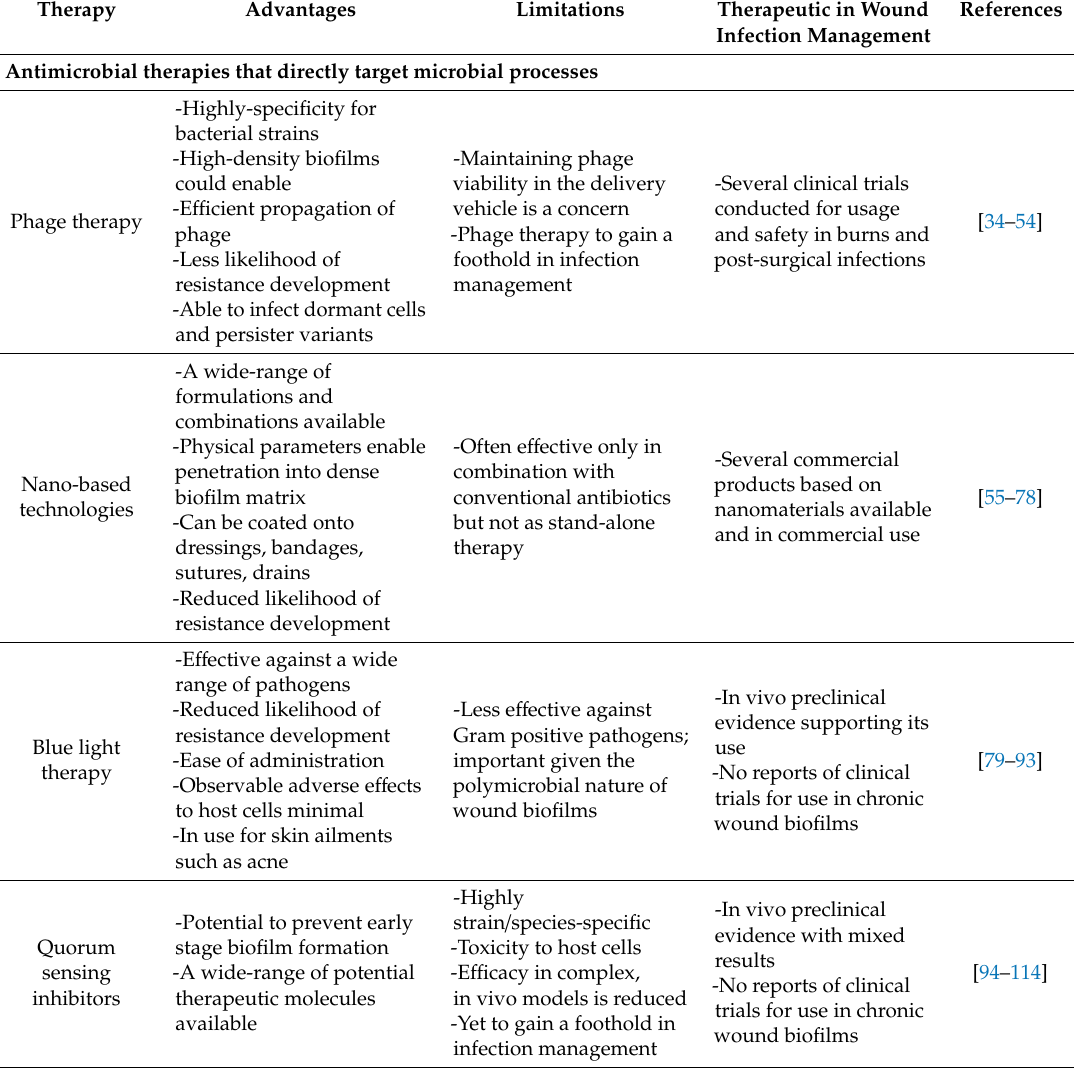
Table 1. Summary of non-conventional antimicrobial approaches for chronic wound biofilms.